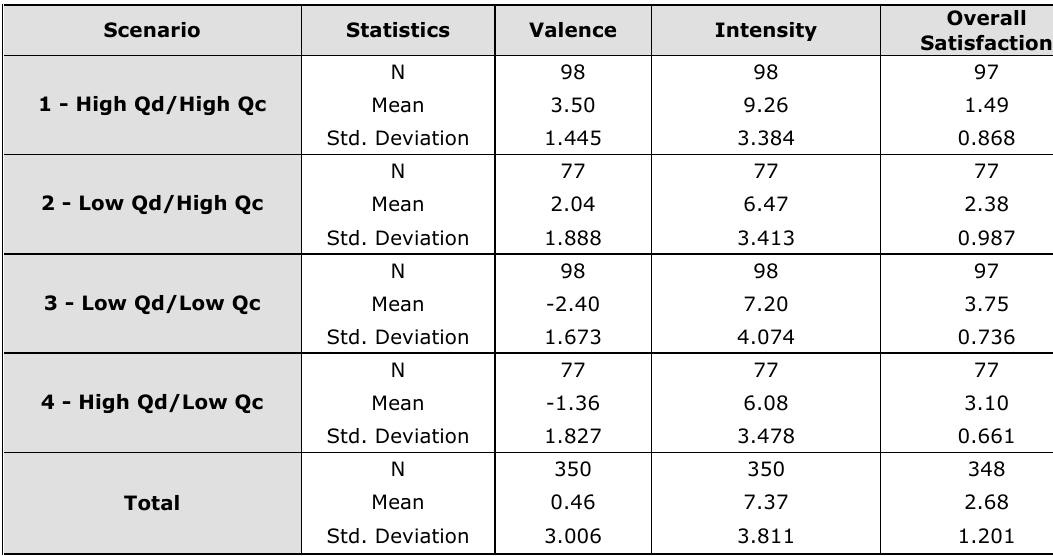
Table 3. “ Descriptive statistics for total valence, total Intensity and overall satisfaction across 4